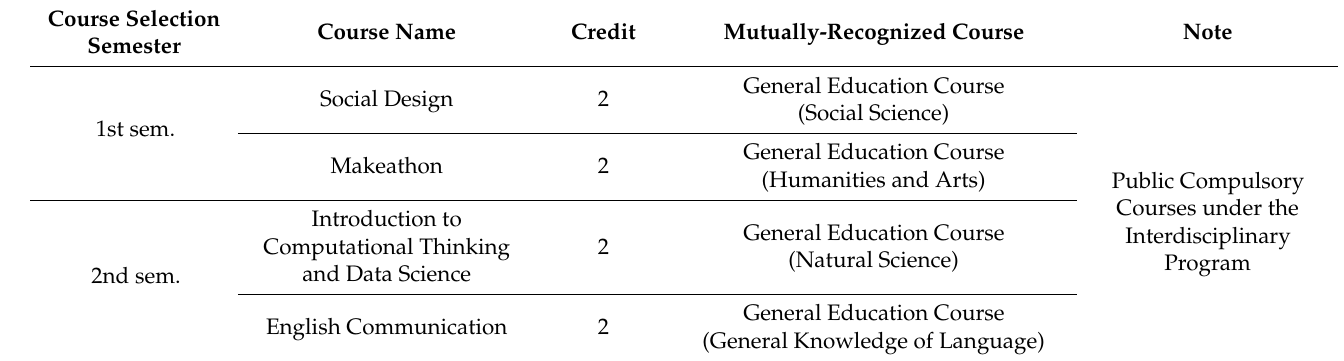
Table 2. The Interdisciplinary